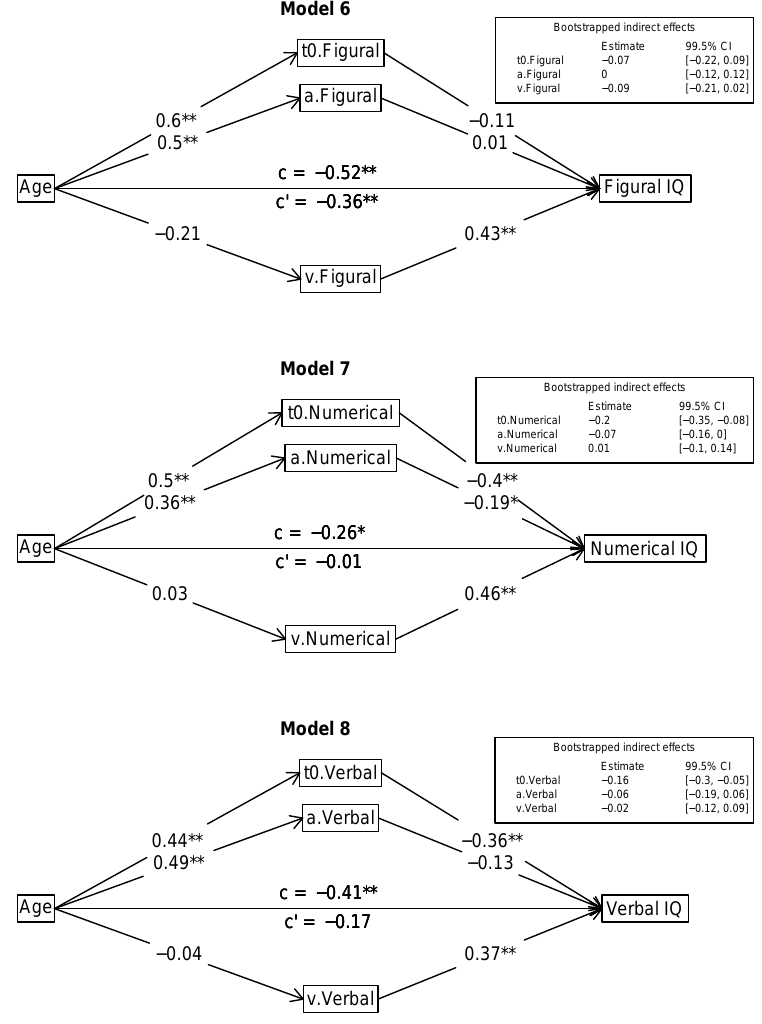
Figure 4. Mediation models for content domains. Standardized estimates are reported. * p < 0.005, ** p <